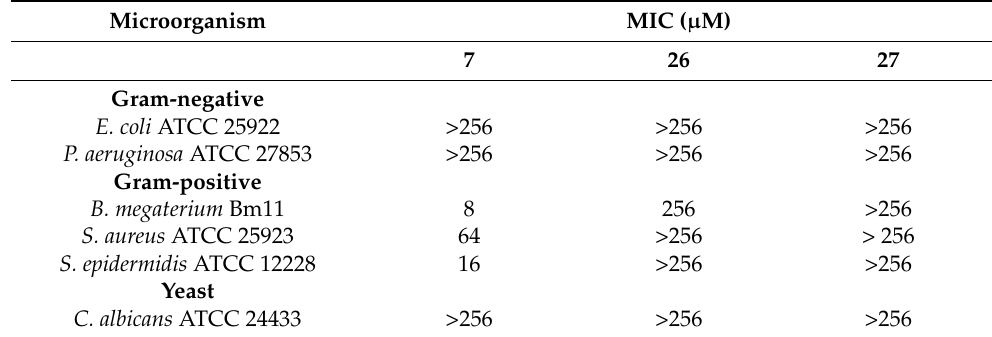
Table 4. Antimicrobial activity of 7 , 26 , and 27 against a panel of Gram-negative and Gram-positive bacteria, and yeast.